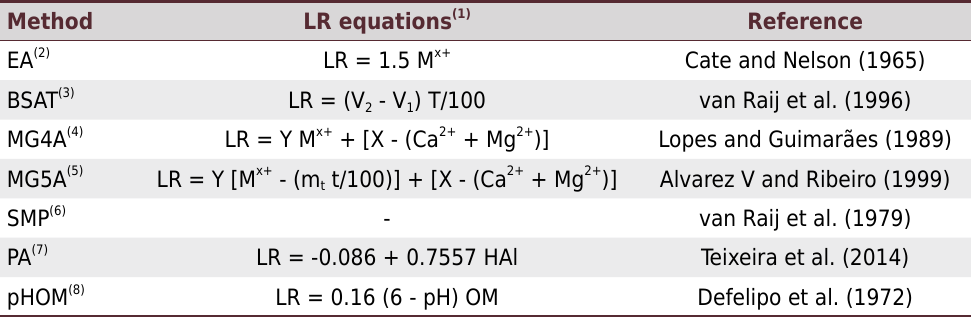
Table 2. Description of traditional methods to determine the lime requirement (LR) used in the lime incubation study